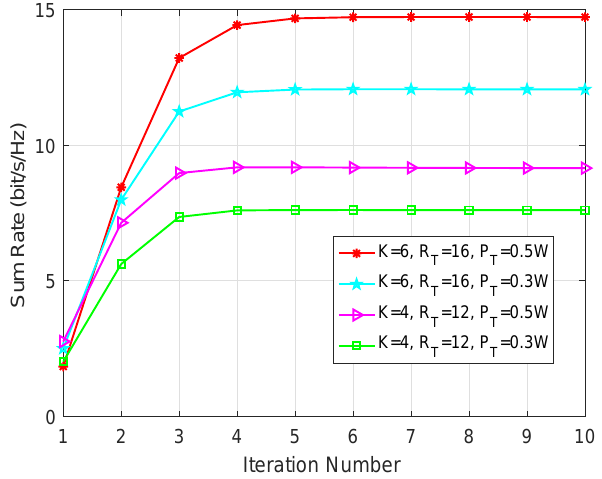
Figure 2. The convergence property of Algorithm